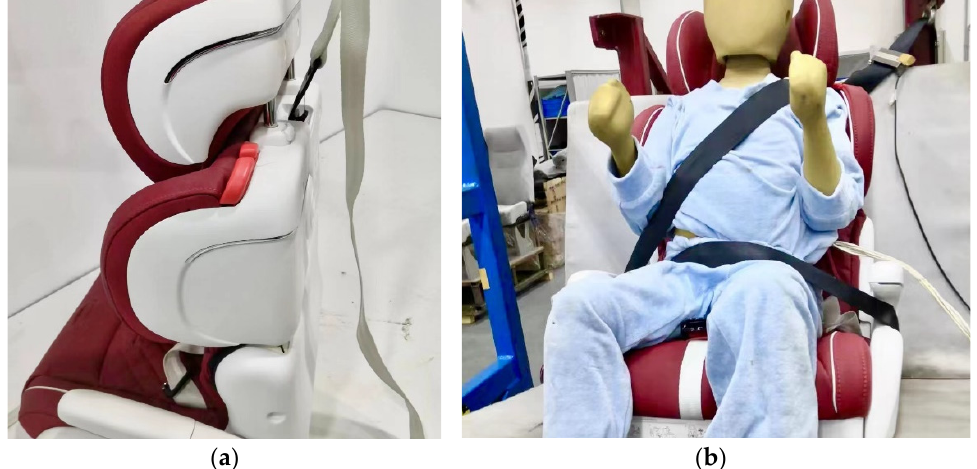
Figure 14. ( a ) Intelligent child restraints can be attached using the flexible Latch belt; ( b ) Intelligent child restraints can be attached using the vehicle seat belt.